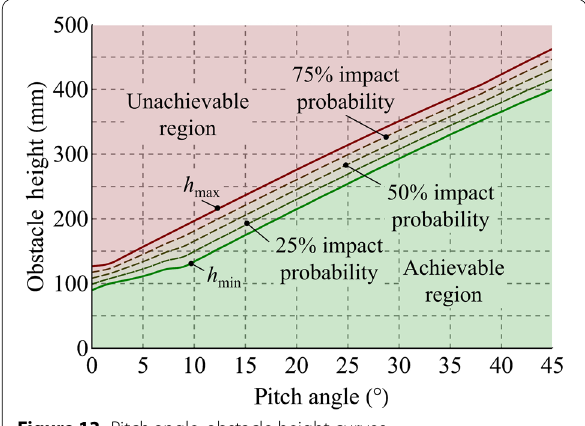
Figure 13 Pitch angle‑obstacle height curves